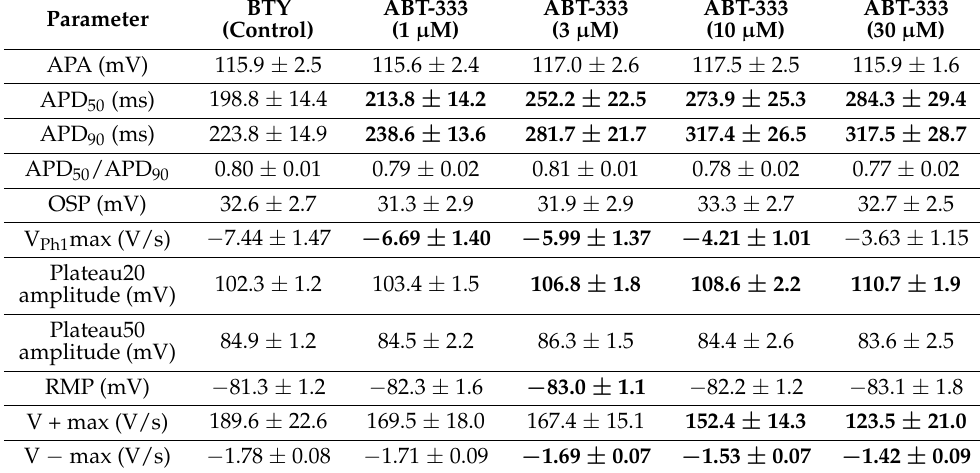
Table 2. AP parameters recorded with increasing ABT-333